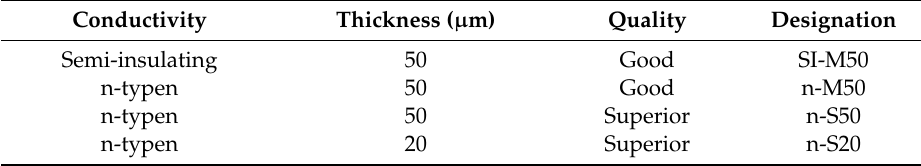
Table 1. Categorization of 4H-SiC wafers used in this